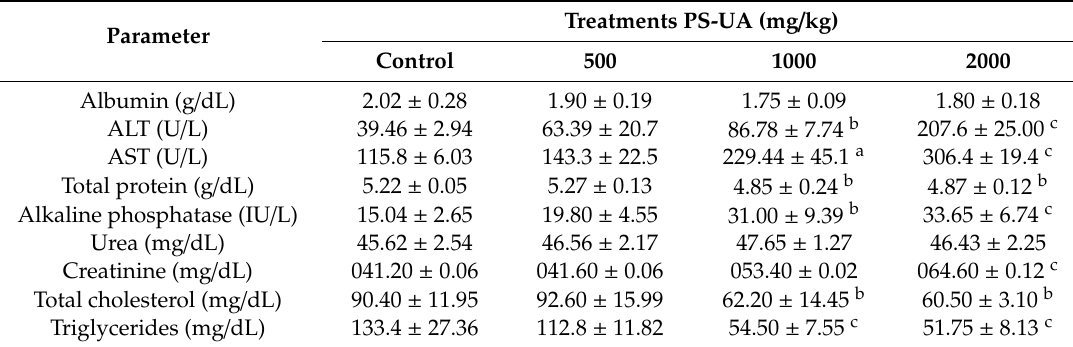
Table 4. The biochemical parameters of the blood of mice treated with PS-UA.